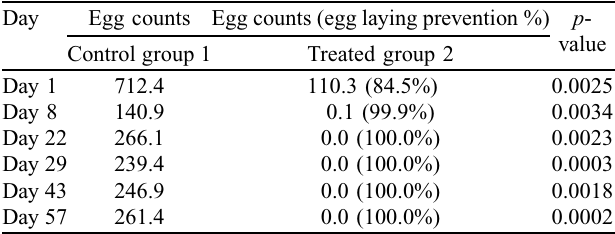
Table 2. Proportion of new fleas obtained from eggs and inhibition of adult flea emergence using arithmetic means.